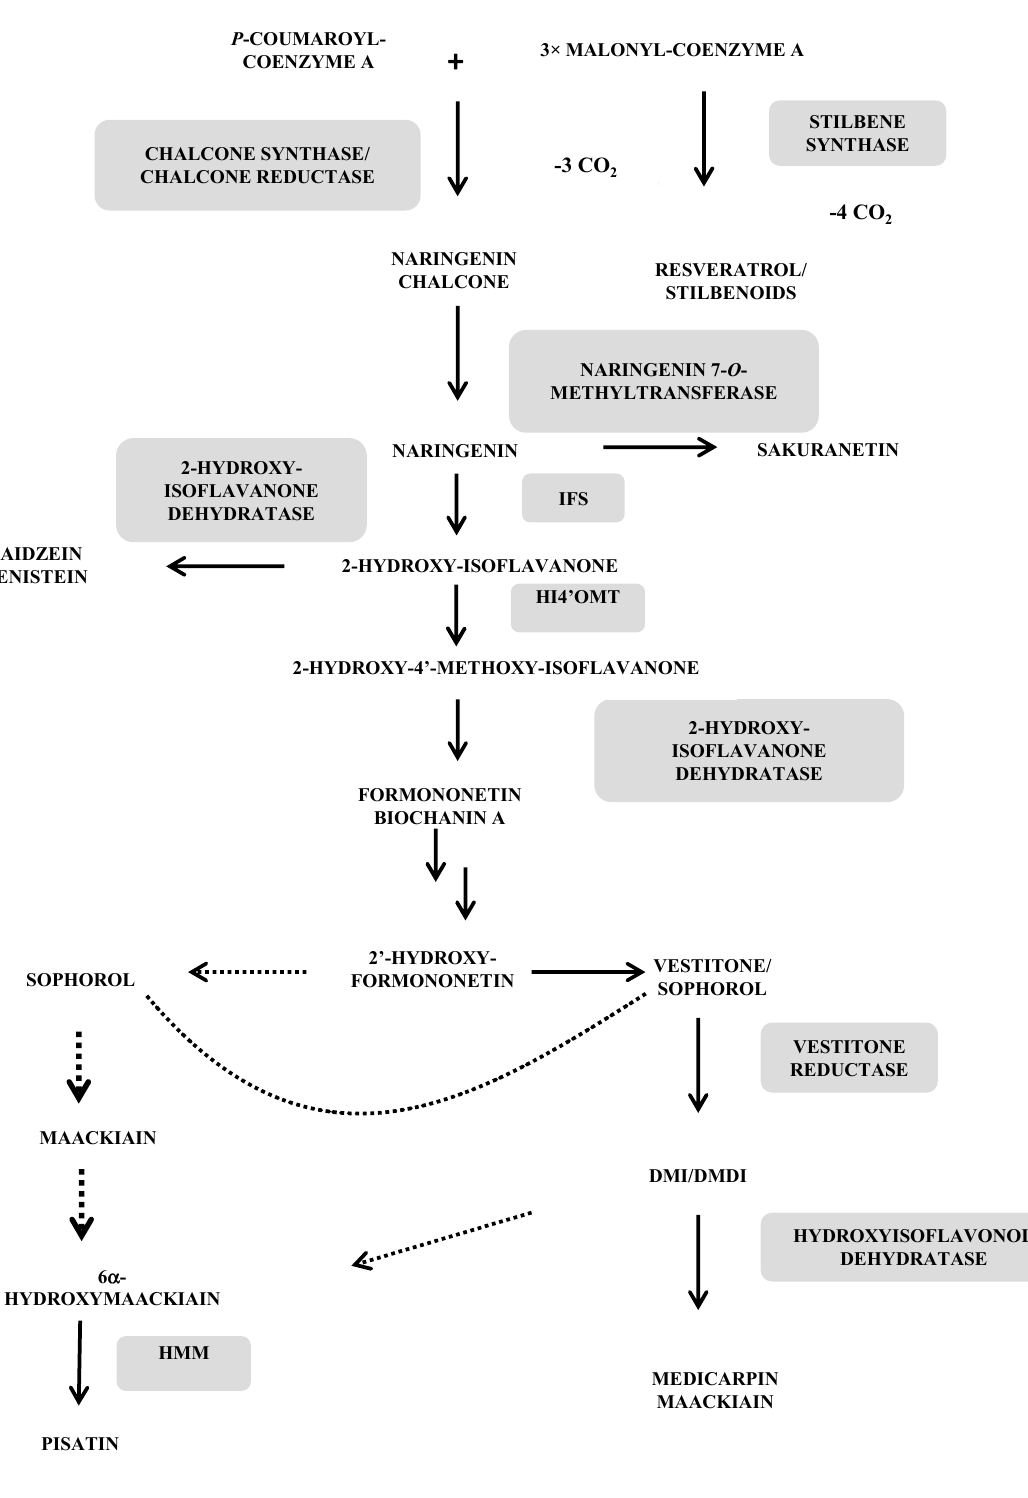
Figure 1. Biosynthetic pathways to the main flavonoid and stilbenoid phytoalexins from the Leguminosae family. (adapted from [10,38,39]). The dashed arrows represent hypothetical steps and the solid arrows denote reactions for which the catalyzing enzymes have been